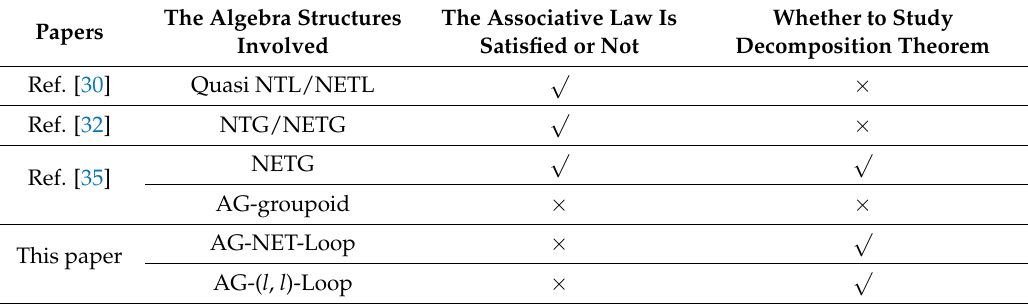
Table 1. The differences between the contents and results of several related papers.